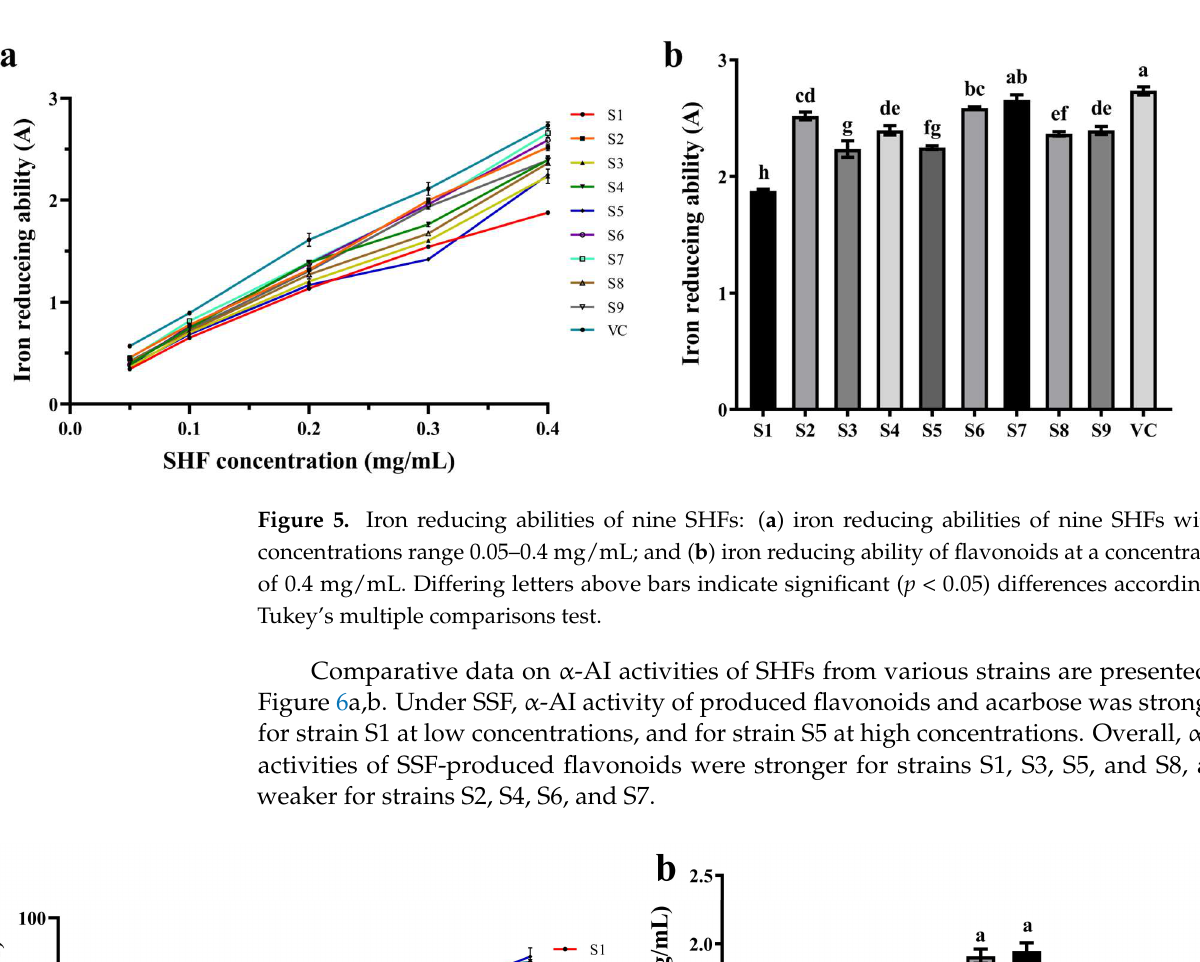
Figure 4. DPPH radical scavenging abilities of nine SHFs: ( a ) DPPH radical scavenging abilities of nine SHFs within concentration range 0.002–0.05 mg/mL; and ( b ) IC 50 for DPPH radicals. Differing letters above bars indicate significant ( p < 0.05) differences according to Tukey’s multiple compari- sons test.